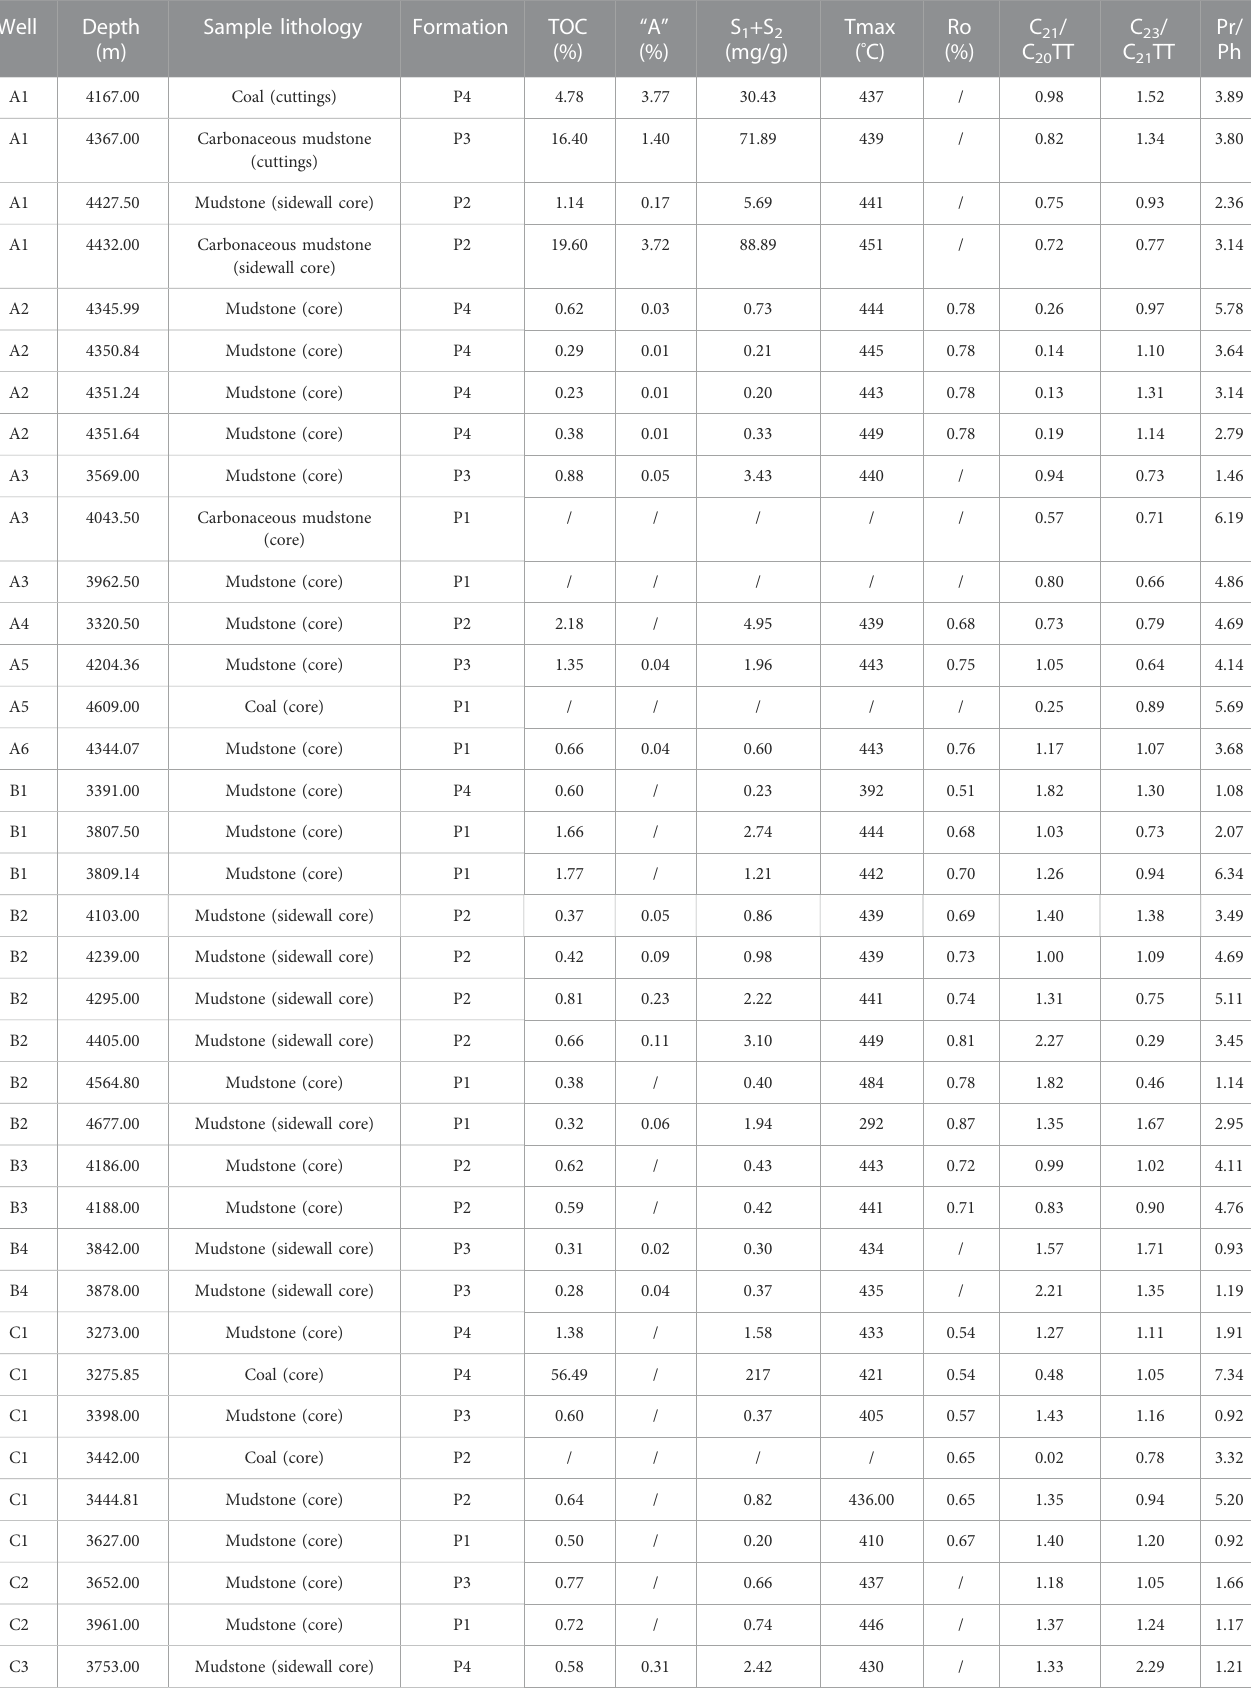
TABLE 3 Geochemical data of sedimentary rock in the Pingbei area, East China Sea